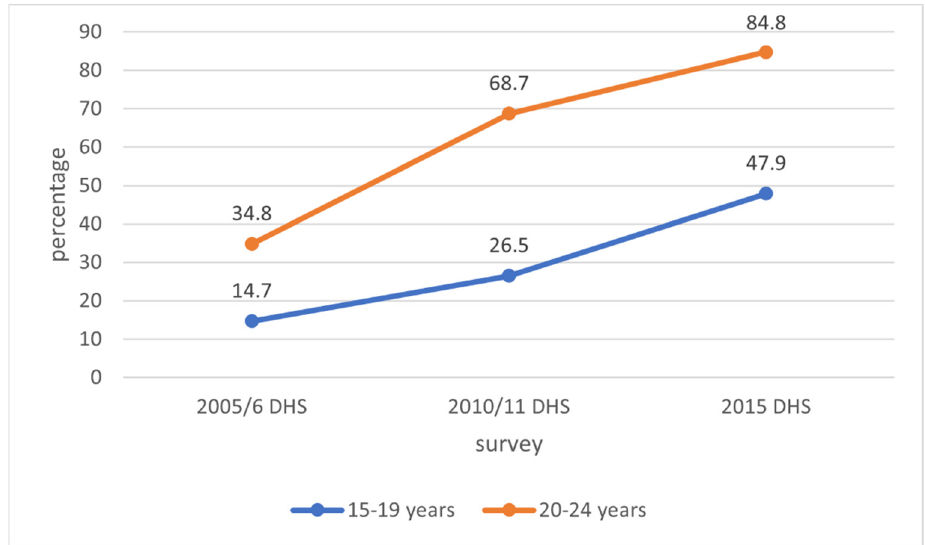
Figure 1. Trends in ever having an HIV test among adolescent girls and young women in Zimbabwe, 2005 to 2015.